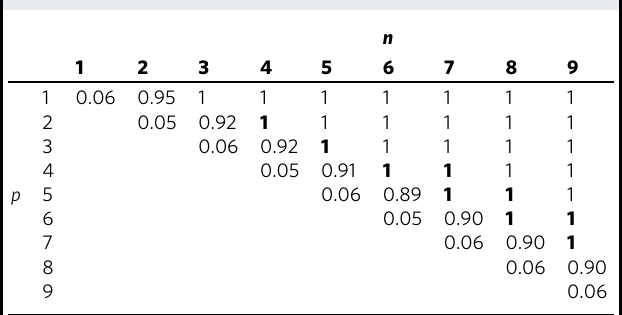
Table 1 Probability of convergence to synchronization from a random initial